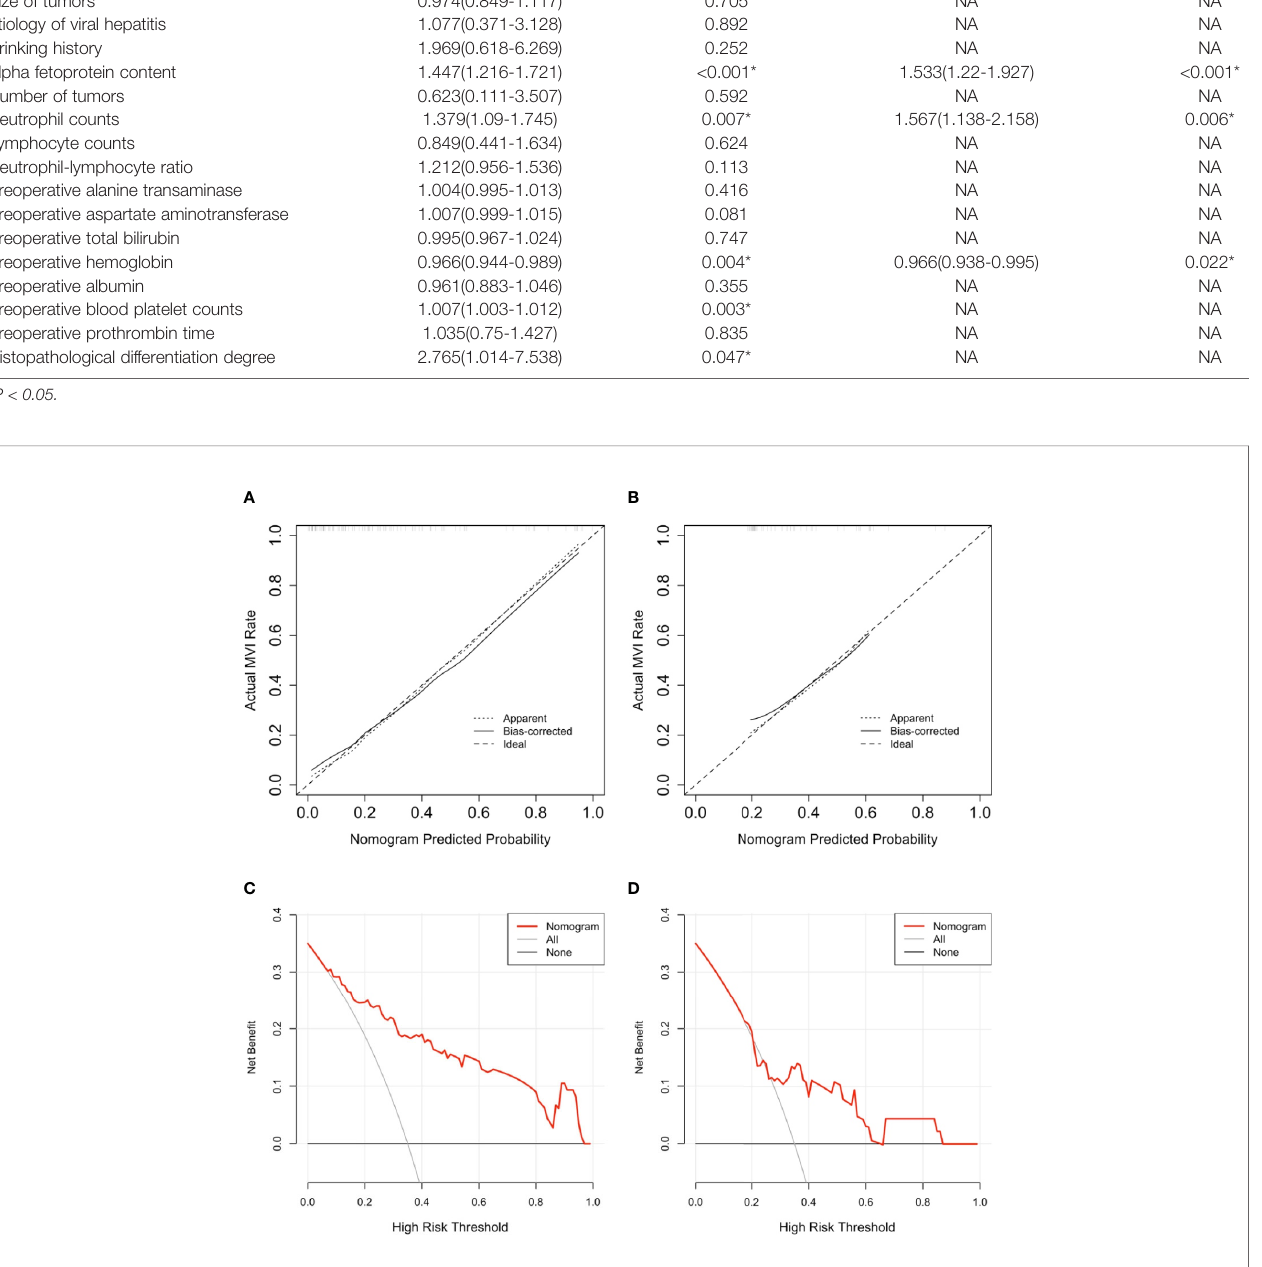
FIGURE 4 | The result of calibration curve analysis as well decision curve analysis for the purposed nomogram. (A, B) show the calibration curves analysis for the nomogram in predicting whether tumors with microvascular invasion occurrence among training cohort as well as validation cohort, respectively. the dashed line stands for perfect prediction, the dotted line represents apparent estimates of predicted vs. observed values, meanwhile the solid line on behalf of bias correcting estimates employing 1,000 bootstrap sampling. (C, D) show the result of decision curve analysis for the nomogram in predicting whether tumors with microvascular invasion occurrence among training cohort as well as validation cohort, respectively. The result of decision curve analysis indicated that assume the threshold probability that is located in an interval of 0.2 to 0.86, microvascular invasion (MVI) prediction using the nomogram can give more net bene fi t than by treating either no or all patients in all